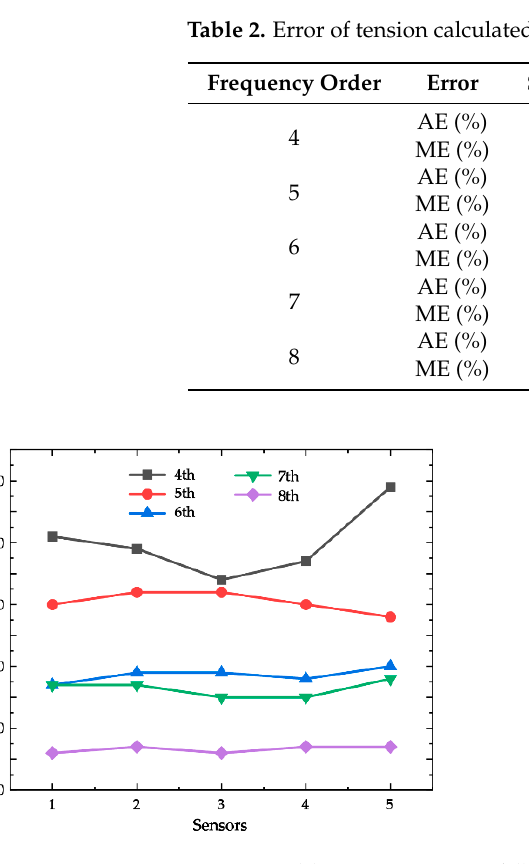
Figure 10. ( a ) Average error and ( b ) maximum error of each sensor. Table 2. Error of tension calculated by each order frequencies.